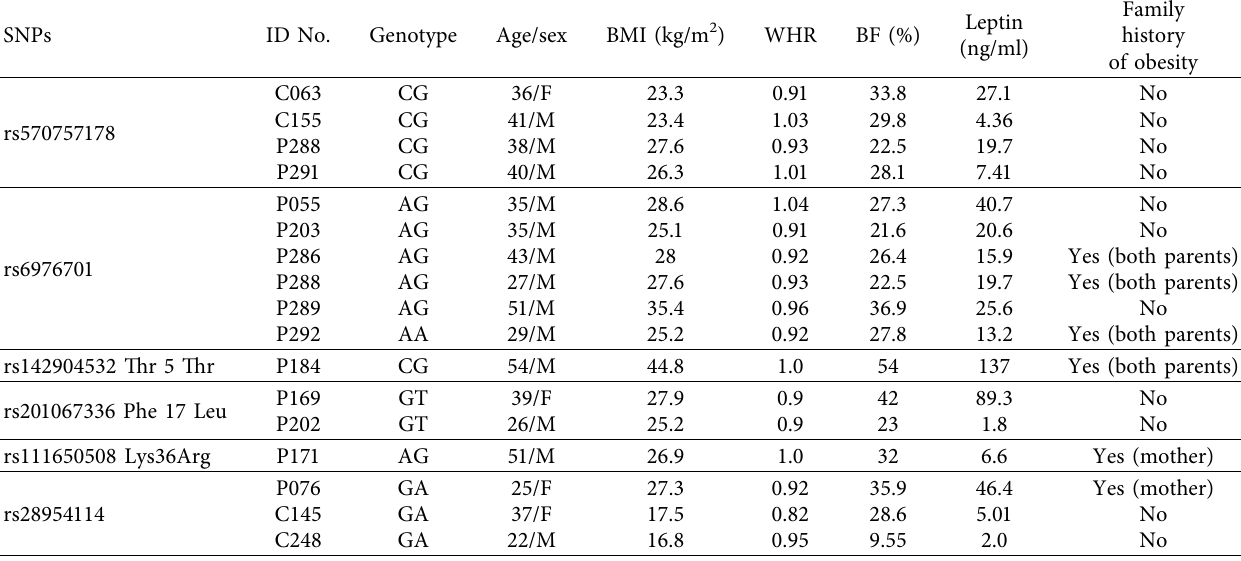
Table 3: Adiposity measures and serum leptin level of subjects with LEP SNPs. SNPs ID